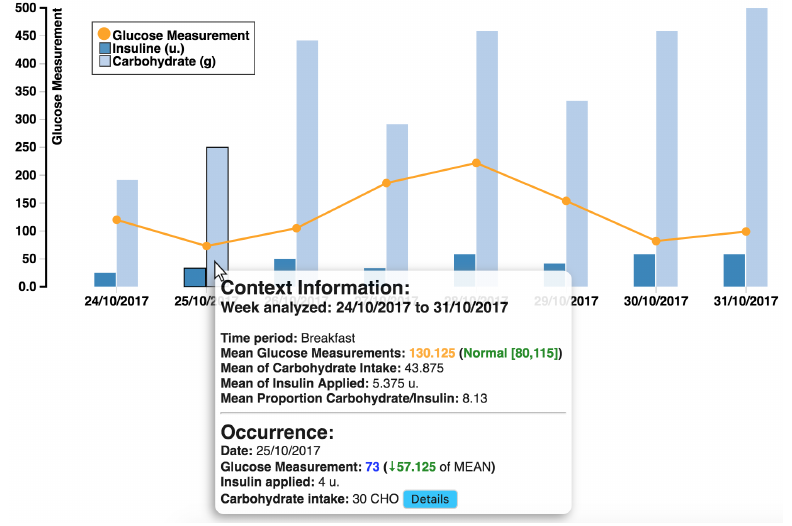
Figure 9. Historical traceability